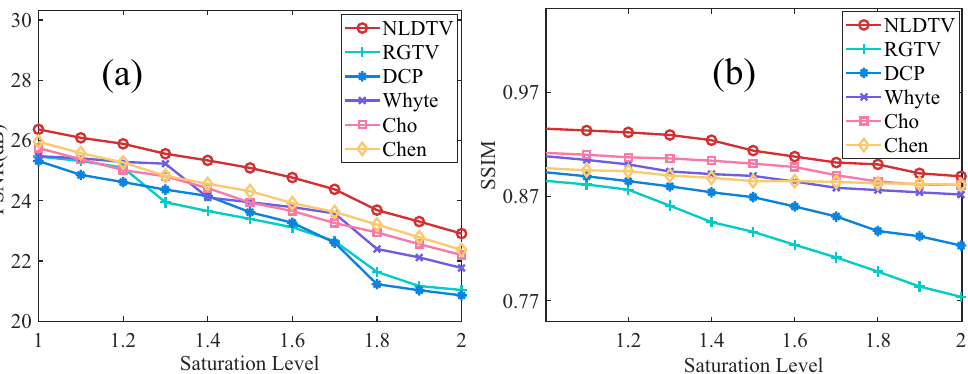
Figure 7. Effectiveness evaluation of different saturation levels. With different saturation levels τ = [ 1.0,2.0 ] , we show the ( a ) PSNR and ( b ) SSIM values of different methods.